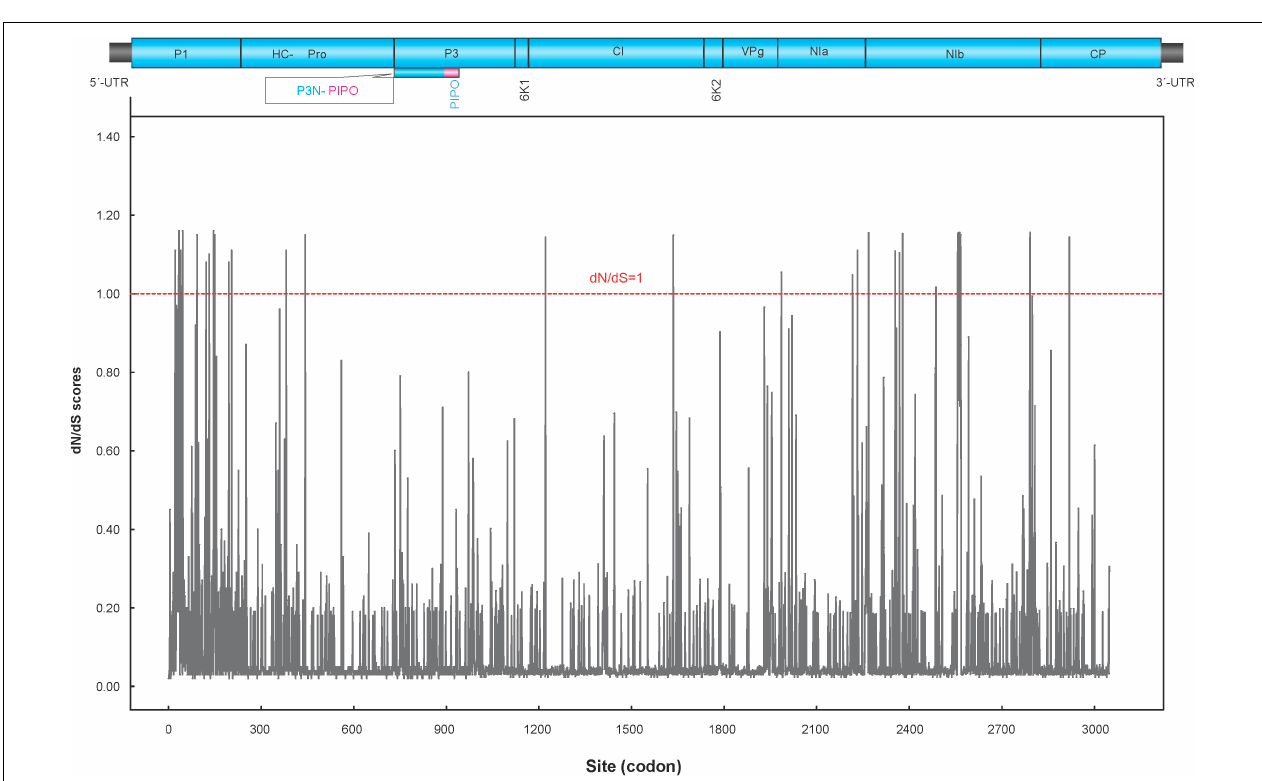
FIGURE 4 | Sliding window plot of d N/ d S ratios across the complete PVA genome. The red dotted line indicates sites under neutral selection ( d N/ d S = 1). A diagram showing the genomic structure of the PVA genome is shown in the top